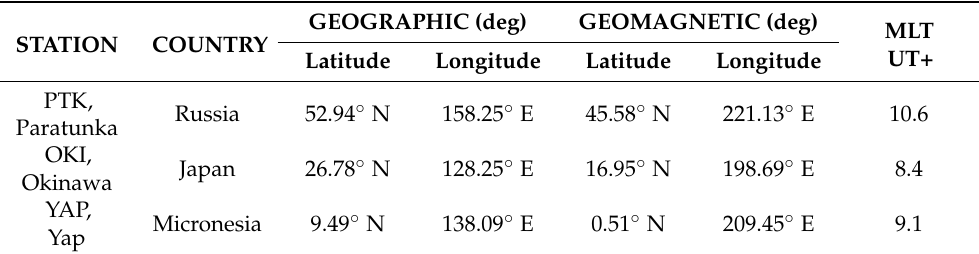
Table 1. List of the National Institute of Communications and Technology (NICT) space weather monitoring magnetometer stations.